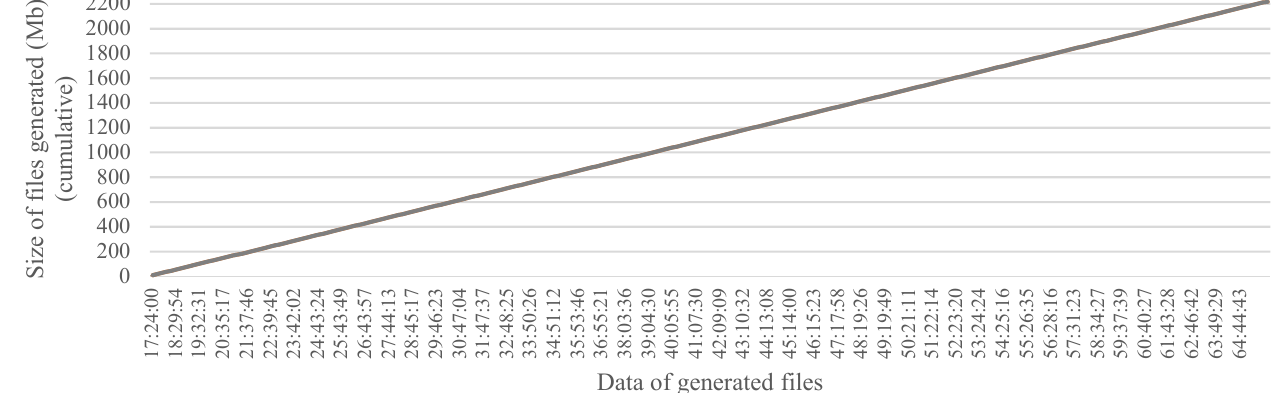
Figure 15. Size of files generated (cumulative). Figure 15 . Size of files generated (cumulative).